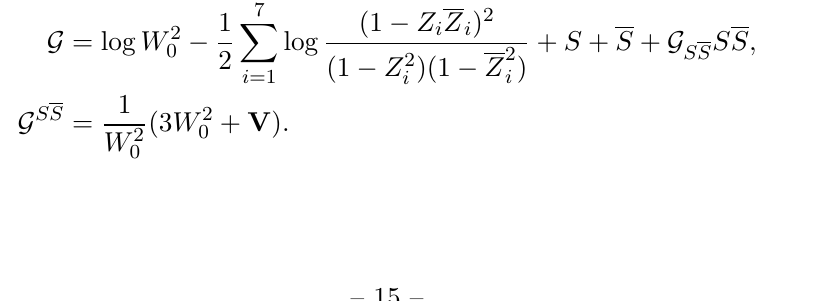
(cid:29) 1 and (cid:0) (cid:30) (cid:29) 1, or with (cid:0) (cid:30) (cid:29) 1 1 2 1 = (cid:30) in the potential shown in (cid:12)gure 5, and eventually 1 2 = (cid:30) = 0. One may call this multi-stage process a 1 2